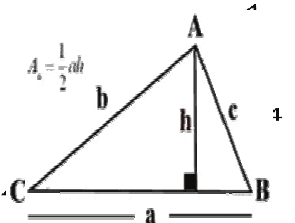
Figure 2. Selected pictures and on ‐ text screen of triangle's types by angles and sides and a way to calculate triangle's